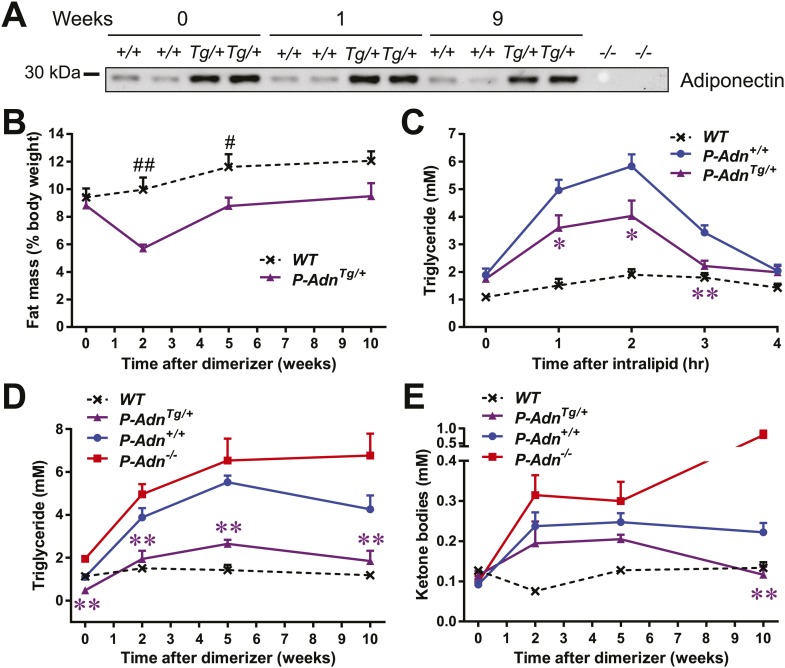
Adiponectin improves systemic lipid metabolism in PANIC-ATTAC mice.(A) Serum samples were collected from P-Adn+/+ (+/+) and P-AdnTg/+ (Tg/+) mice, 0, 1, and 9 weeks after initial dimerizer treatment and subjected to Western blotting for adiponectin. Equal volume of serum was loaded for each lane. Serum samples from adiponectin knockout mice (−/−) were included as negative controls. (B) Fat mass presented as percentage of mouse body weight (BDW). (C) Blood triglyceride during oral triglyceride tolerance test in mice 2 weeks after initial dimerizer treatment. (D and E) Plasma triglyceride (D) and total ketone bodies (E) in mice under fed status. Data of WT, P-Adn+/+, and P-Adn−/− at week 10 were presented in Figure 1G,H. For B to E, n ≥ 5 mice per condition. Data are presented as the mean ± SEM. *p < 0.05, **p < 0.01 for P-AdnTg/+ vs P-Adn+/+. #p < 0.05, ##p < 0.01 for WT vs P-AdnTg/+.